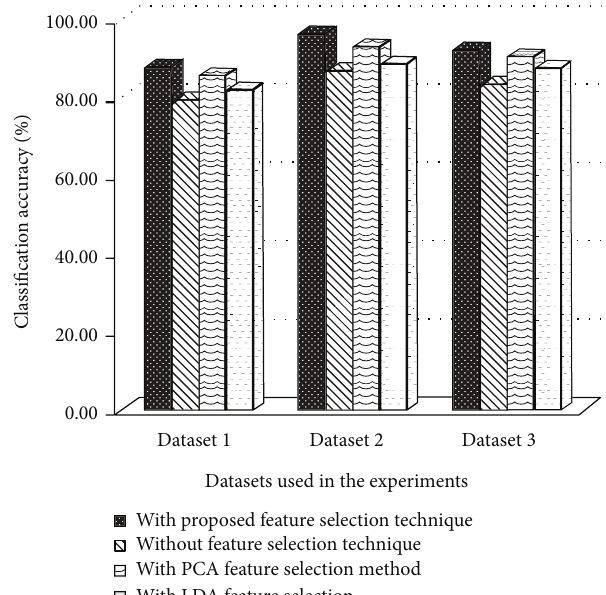
Figure 9: Significance of the feature subset selection technique on classification accuracy of three datasets.